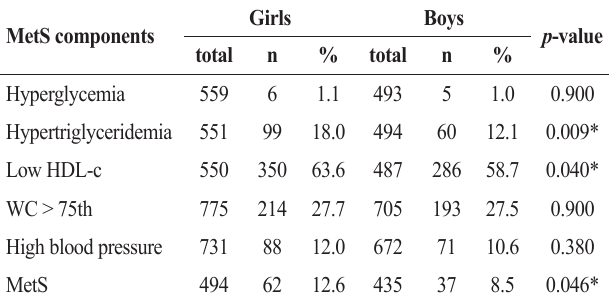
Table 1. Proportion of boys and girls meeting each of the